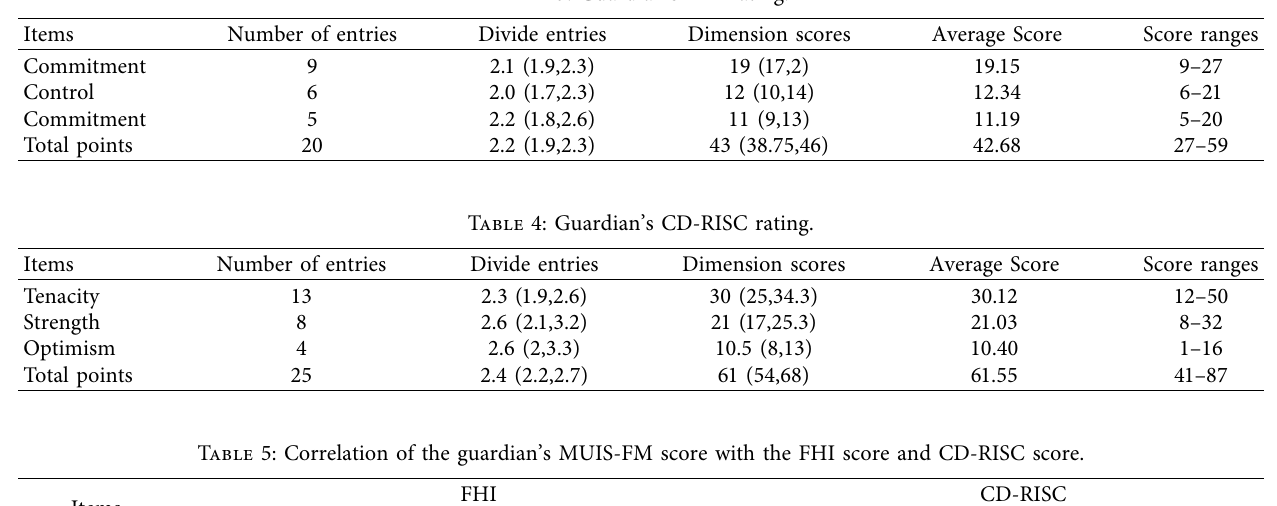
Table 3: Guardian’s FHI rating.